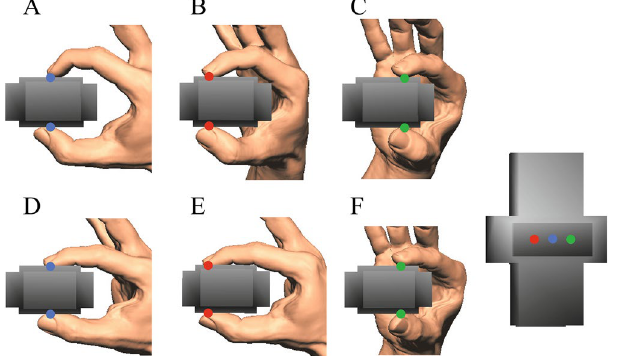
Figure 4. Six measured conditions. We asked the participant to pinch the center, far side, and near side of the device with fingertips ( A , B , and C , respectively) and finger pulps ( D , E , and F , respectively), and the forces applied to the device and the centers of pressure were